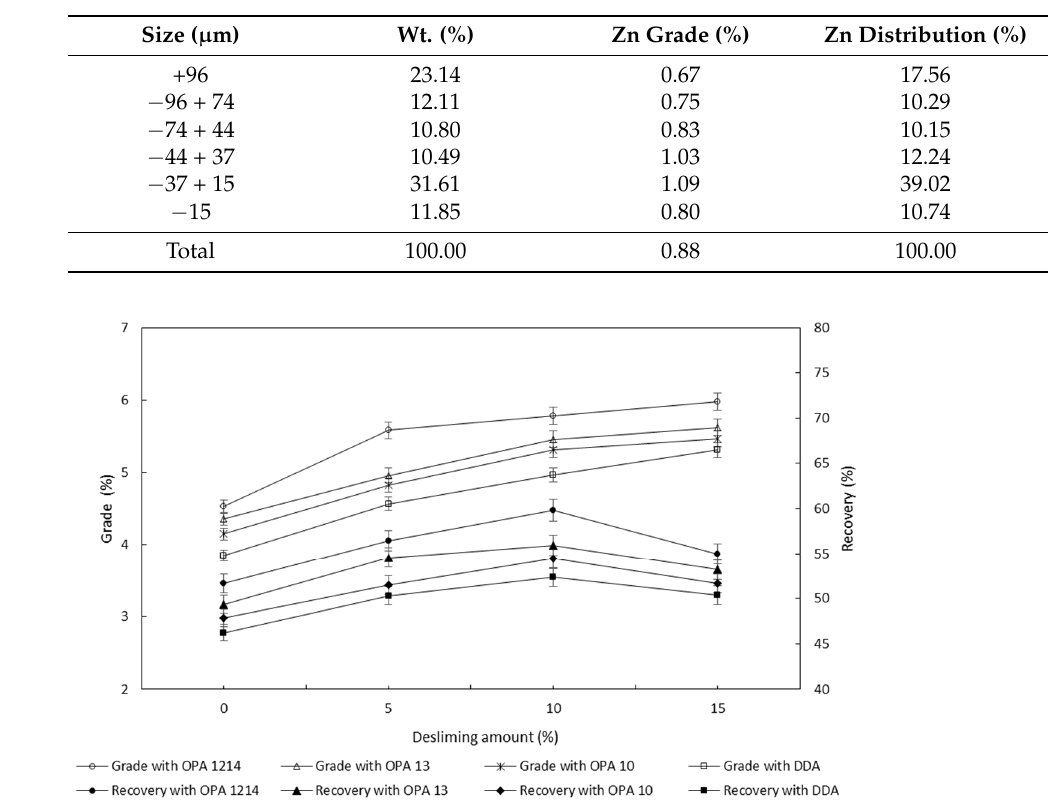
Figure 3. Concentrate Zn grade and recovery as a function of desliming